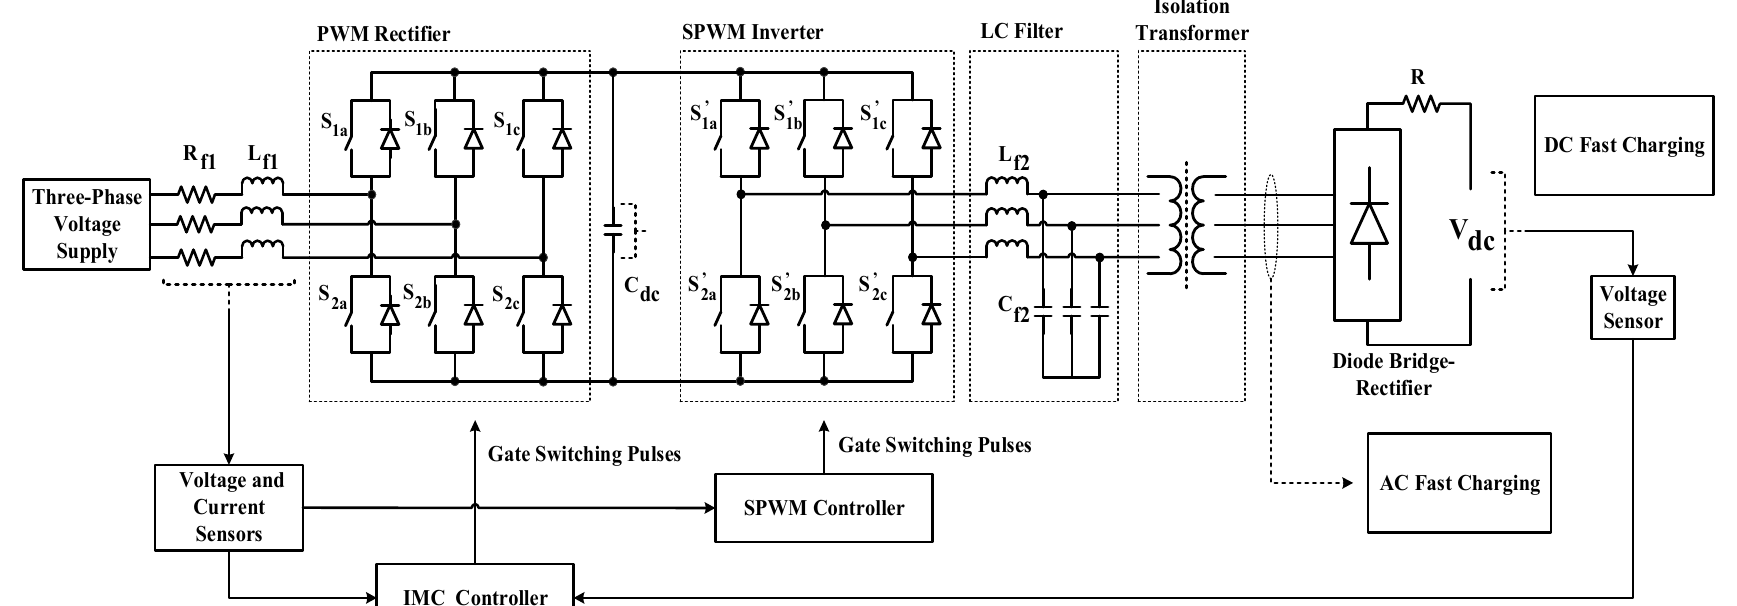
Figure 1. Overall structure of the proposed electric vehicle (EV) fast charger.